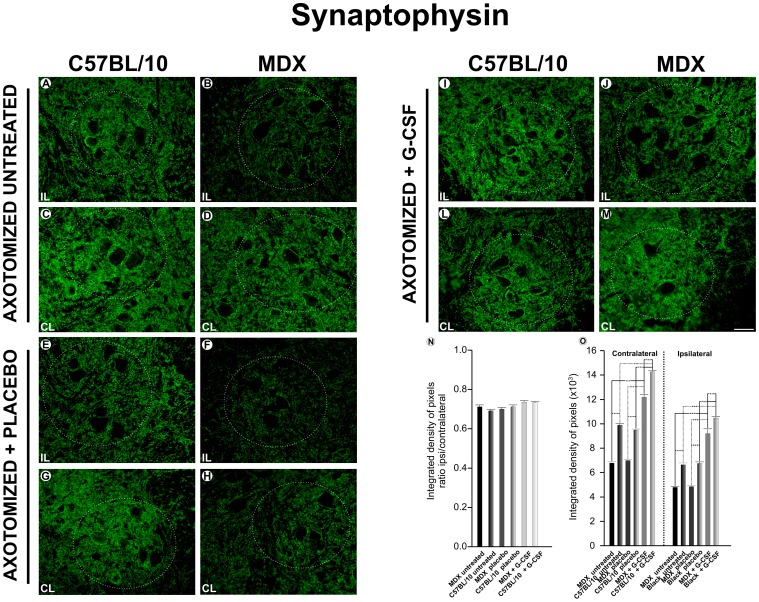
Anti-synaptophysin immunostaining one week after axotomy.
A and C, the ipsilateral (IL) and contralateral ventral column of the spinal cord of the C57BL/10 strain seven days after axotomy; B and D, the ipsilateral and contralateral ventral column of the spinal cord of the MDX strain seven days after axotomy; E and G, the ipsilateral and contralateral of the C57BL/10 ipsilateral+ placebo group seven days after the axotomy; F and H, the ipsilateral and contralateral of the MDX ipsilateral+ placebo group; I and L, the ipsilateral and contralateral of the C57BL/10 ipsilateral+ G-CSF group; J and M, the ipsilateral and contralateral of the MDX ipsilateral+ G-CSF group. N and O, the quantitative analysis of the integrated density of pixels between the ipsi/contralateral ratio and right and left sides, respectively. The circled areas show the motor nucleus of the sciatic nerve and alpha-motoneurons of each lineage. In all experiments: n = 5. In A–M, magnification, X200 (scale bar, 50 µm). The alpha-motoneurons were quantified in 3 distinct fields along the lumbar intumescence. In N, ***p<0.001 vs. CT, values are means ± SEM.